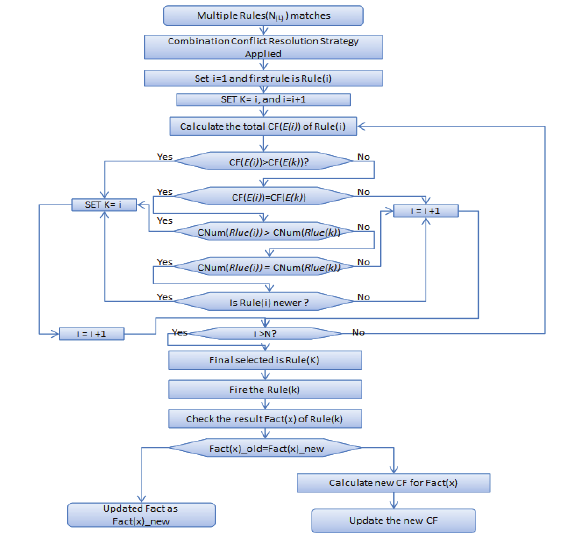
Fig. 7. Progress of the Conflict Resolution Strategy